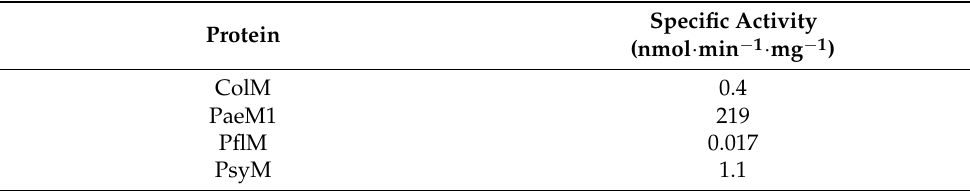
Table 3. Specific activities of ColM and its homologues PaeM1, PflM and PsyM originating from P. aeruginosa , P. fluorescens and P. syringae , respectively (after